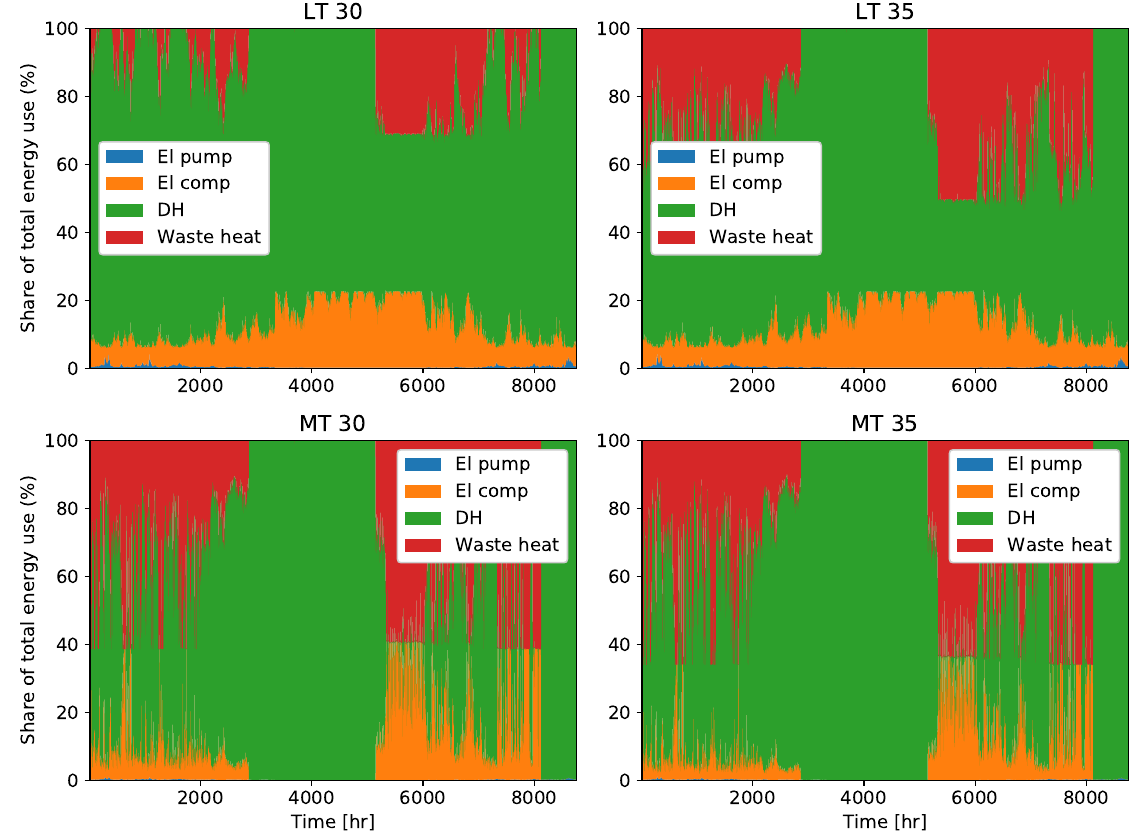
Figure 5. The share of the total energy use of the local heating network covered by the different energy sources for the four simulated cases.